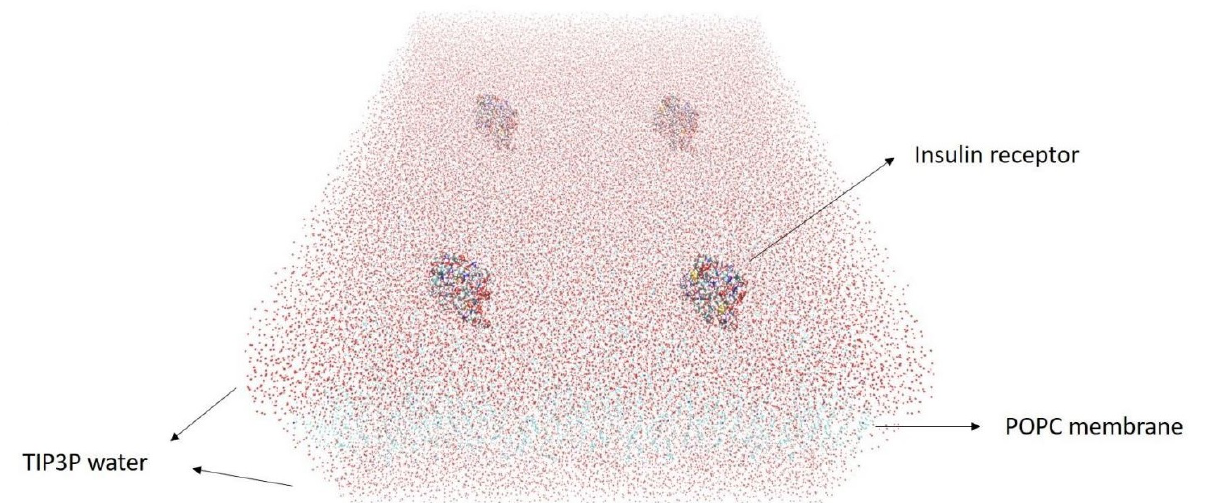
Figure 4. 200 A ◦ × 200 A ◦ embedded membrane with four receptors and two 15 A ◦ layers of